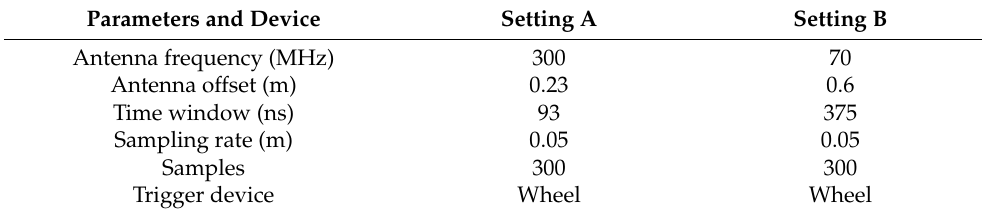
Figure 6. Diagram of the field GPR survey on QTH: ( a ) GPR survey system; ( b ) site survey. Table 1. Parameter setting of